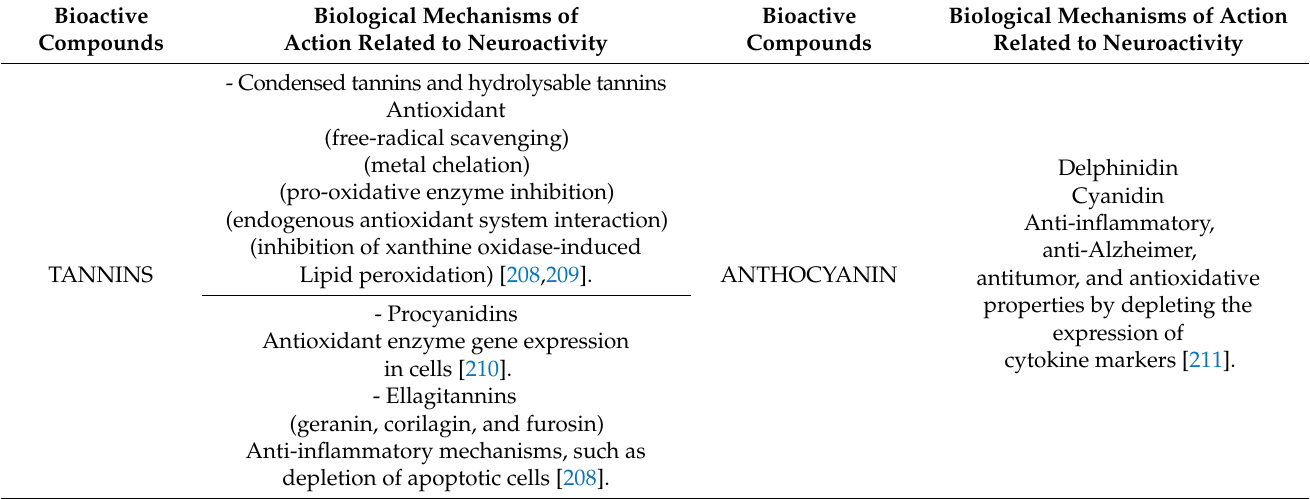
Table 2. Other neuroprotective-related bioactivity mechanisms of key bioactive